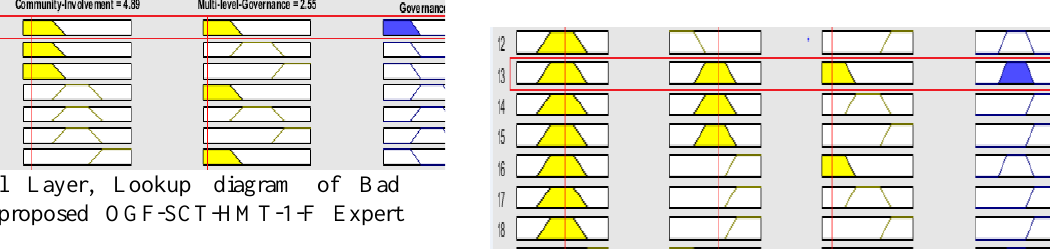
Figure 5b . Final Layer, Lookup diagram of satisfactory Governance for proposed OGF-SCT-HMT-1-F Expert System